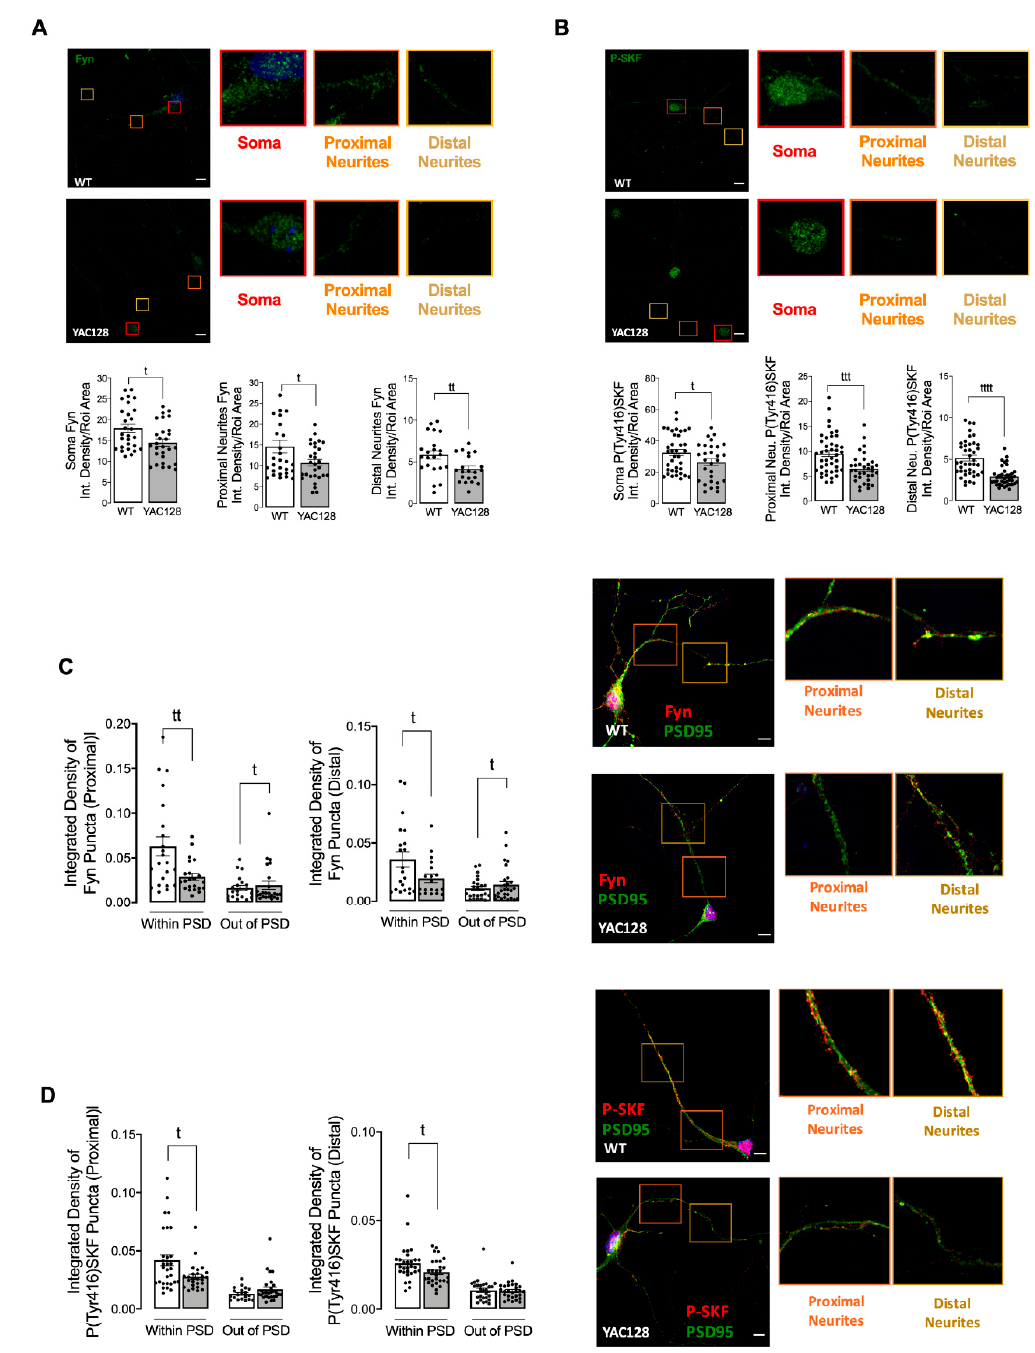
Figure 2. Reduced total and phosphorylated Fyn levels in HD synapses. The total levels of Fyn ( A ) and P(Tyr416)SKF ( B ), as well as, the levels of Fyn ( C ) and P(Tyr416)SKF ( D ) in co-localization with PSD-95, or out of PSD were evaluated by immunocytochemistry in proximal and distal neurites, using confocal microscope and Image J software in YAC128 vs. WT striatal neurons. Confocal im- ages were obtained with a 63× objective in confocal microscope Zeiss LSM 710 (scale bar: 10 μ m). Data are presented as the mean ± SEM of 4 independent experiments analyzing 5 to 8 cells per con- dition per culture. Statistical analysis: t p < 0.05, tt p < 0.01, ttt p < 0.001, and tttt p < 0.0001 versus control conditions (nonparametric Mann-Whitney test).